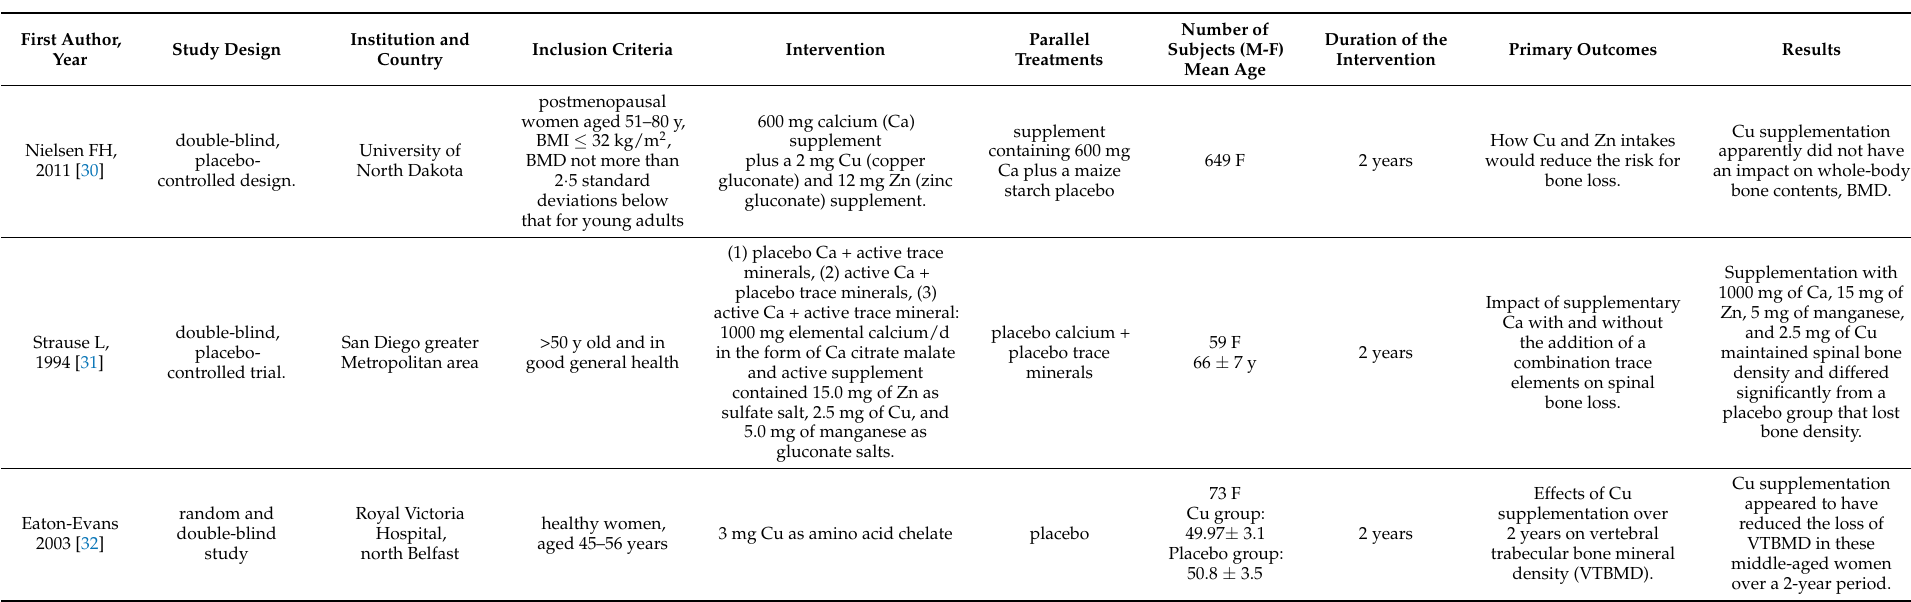
Table 3. Studies that considered copper